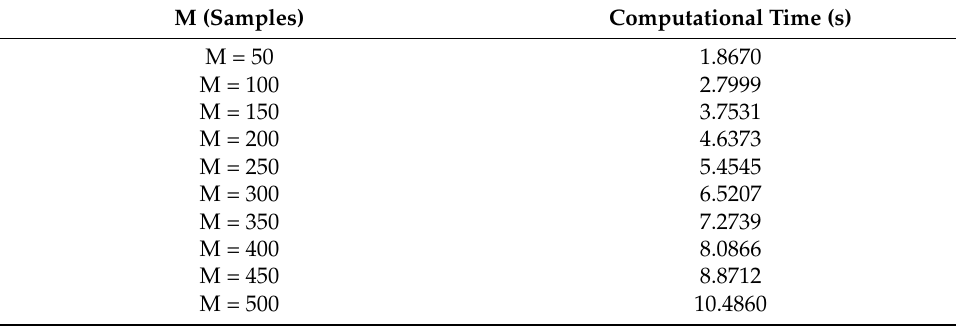
Figure 5. SAR improvements for different values of λ at P = 4 and M = 50.